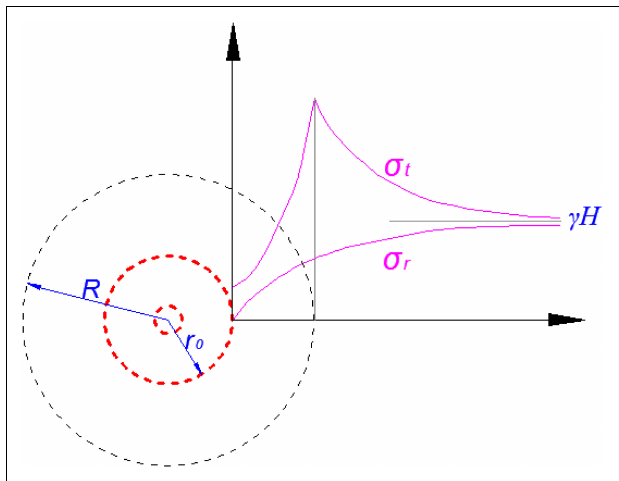
FIGURE 2 | Stress distribution of a vertical circular